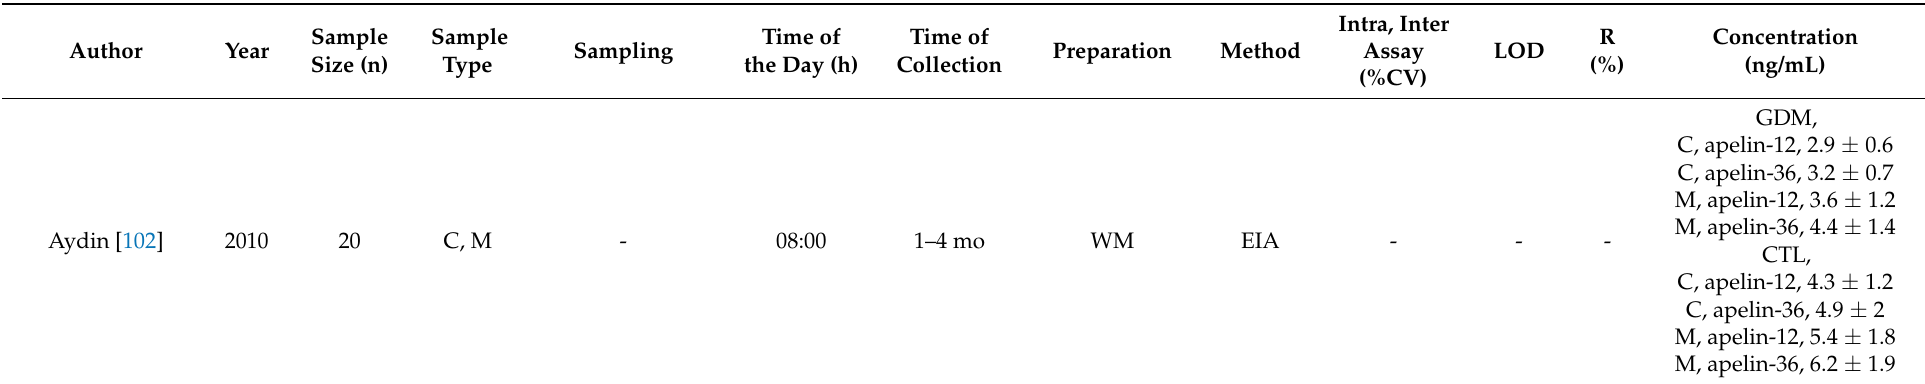
Table 7. Studies examining human milk